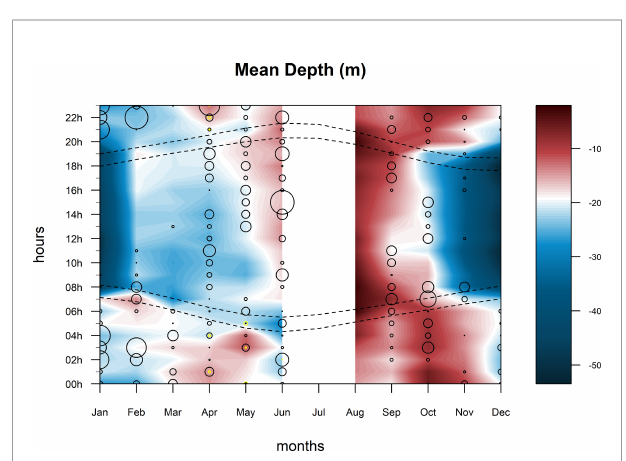
FIGURE 9 | Abacus plot of the average depth across a 300-day deployment period for #4 smooth hammerhead shark ( Sphyrna zygaena ) double-tagged (acoustic and PAT) in the Azores. Dashed lines indicate the times of dawn and dusk across the year; circles represent the detections of this individual in acoustic receivers with the size being proportional to the number of detections; yellow dots signal receivers moored at deep (200 m) acoustic stations on the shelf edge, and hollow circles signal those at shallow (ca. 30 m)